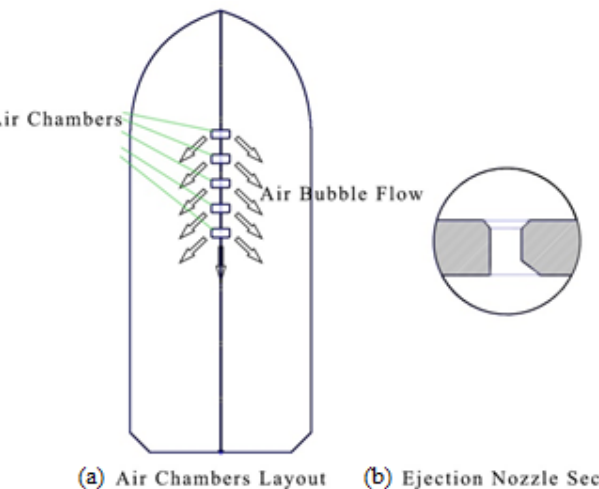
Figure 4. Air vent arrangement and the pressurization chamber of foreship. In the figure, ( a ) repre- sents the arrangement of the air chambers and nozzles, and ( b ) represents the cross-section of the ejection nozzle.